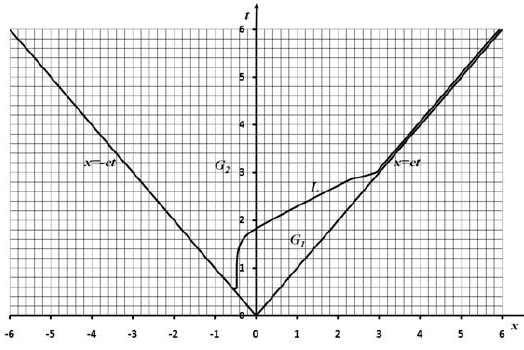
Figure 9: Area G ± c .Graphs of the line L and sets G 1 , G